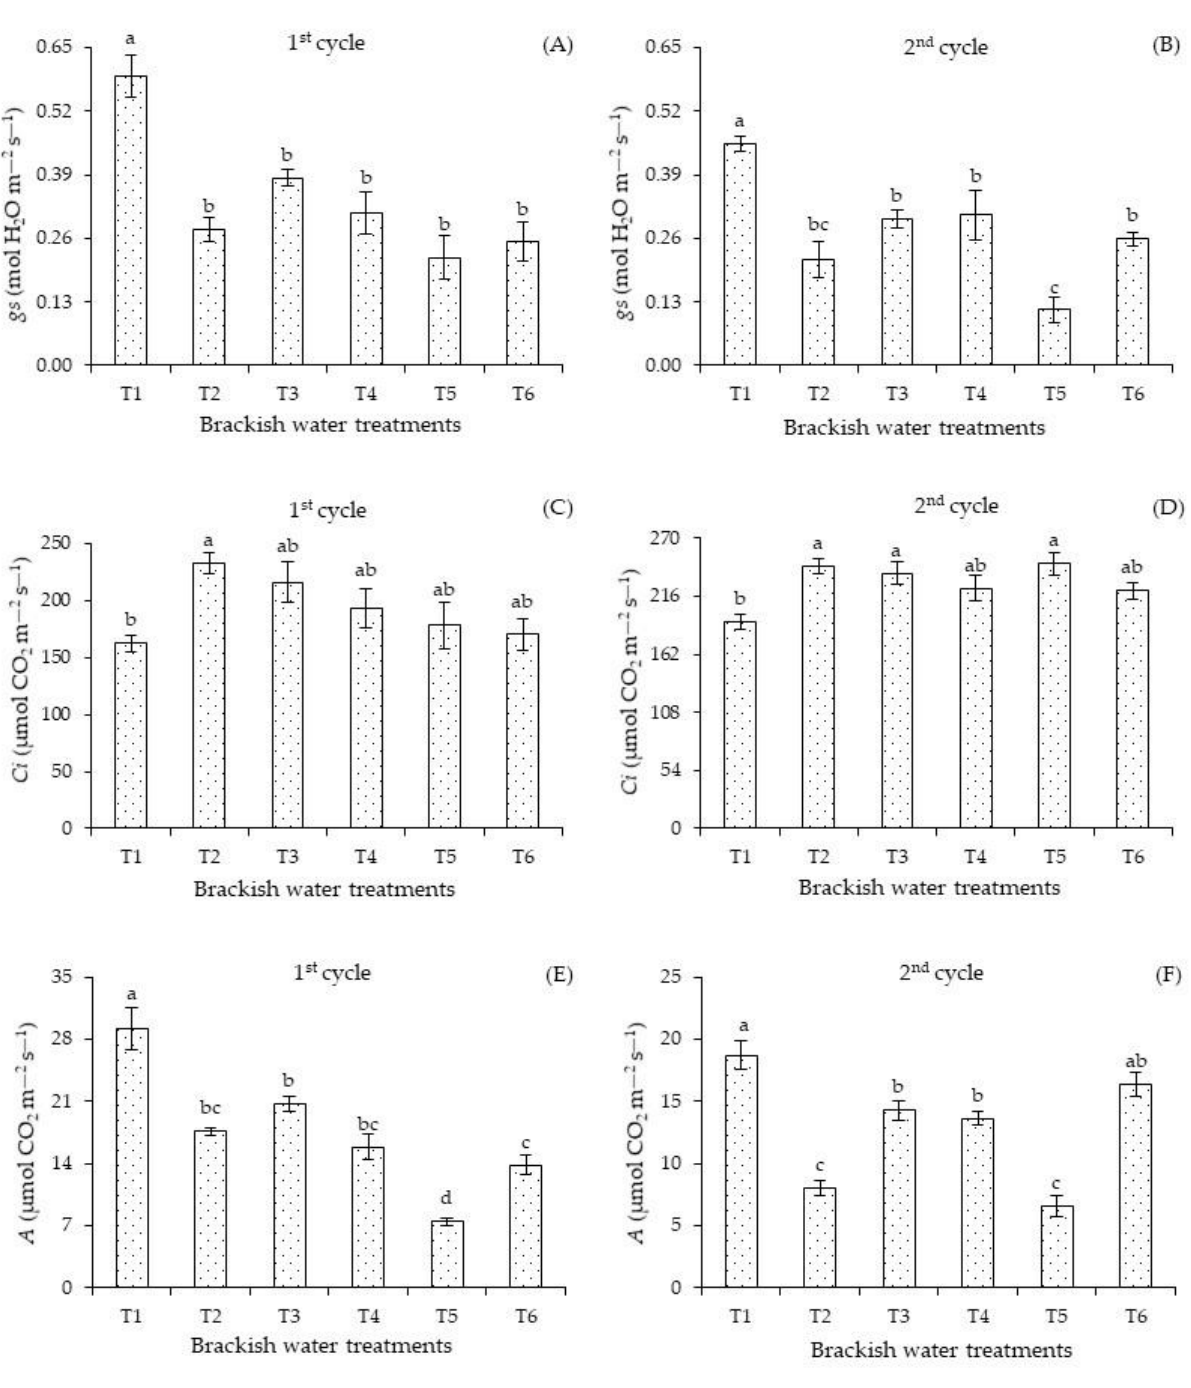
Figure 5. Stomatal conductance— gs ( A , B ), intercellular concentration of carbon dioxide— Ci ( C , D ), and photosynthesis—A ( E , F ) of Passiflora edulis Sims as a function of salt stress, varying the phenological stages in the first (240 DAT) and second (445 DAT) cycle. Standard error of the mean